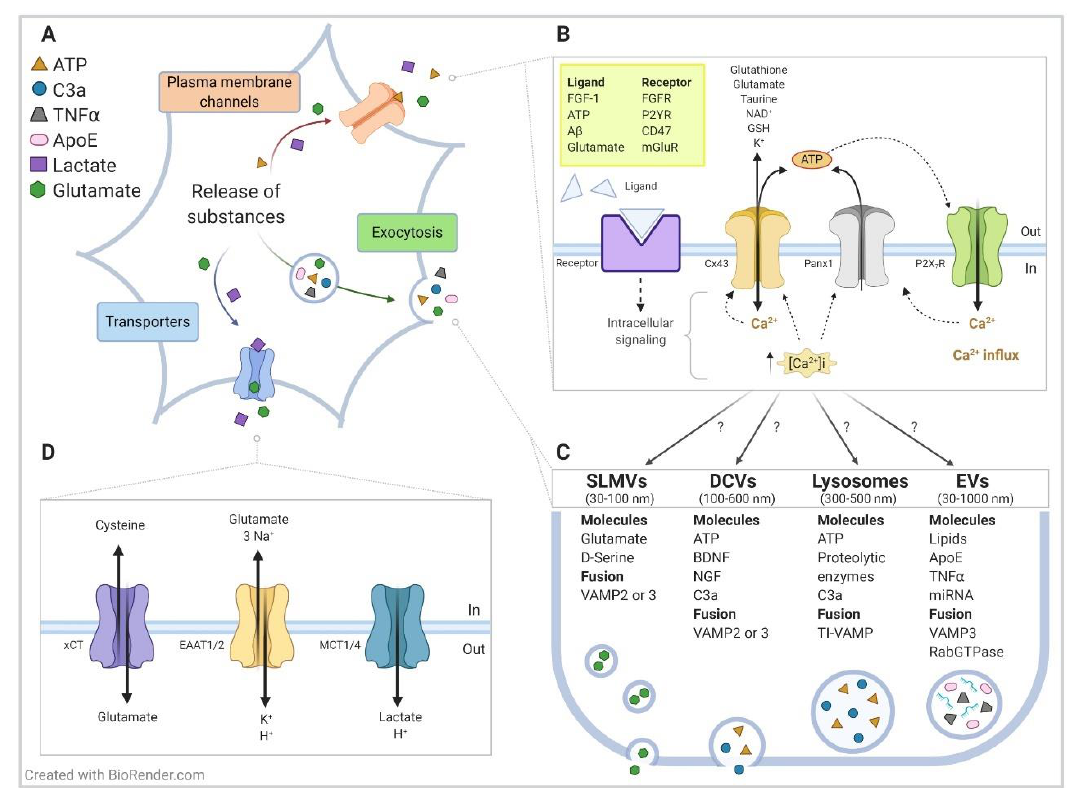
Figure 2. Mechanisms of storage and release of bioactive substances in astrocytes: a focus on neurodegenerative diseases. Box 2: Mechanisms of storage and release of bioactive substances in astrocytes: a focus on neurodegenerative diseases. Model showing ( A ) a general overview and ( B–D ) specific details of the release of signaling molecules from astrocytes into the extracellular space through three classical mechanisms. These mechanisms involve ( B ) diffusion through plasma membrane channels, ( C ) exocytosis, and ( D ) translocation by transporters. For simplicity, we show only a few membrane proteins, along with some bioactive substances and secretion signaling mechanisms that are critical for communicating